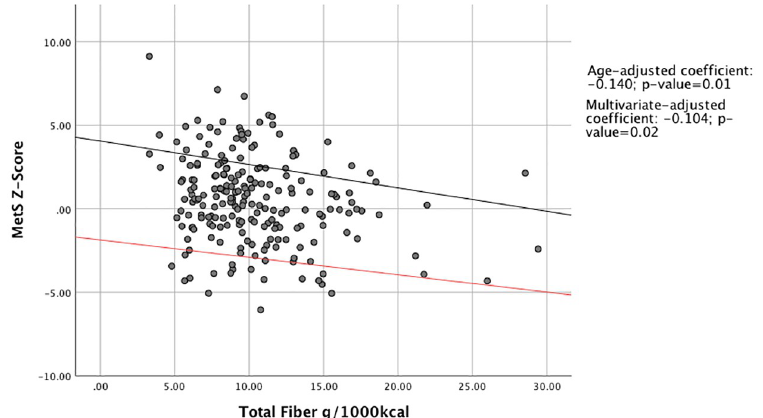
Fig 1. Association between total fiber intake and MetS Z-score. Abbreviations: MetS, Metabolic Syndrome. Linear regression model was used to predict association between daily fiber intake and MetS z-score. The black regression line indicates age-adjusted linear regression, for which the coefficient is -0.140. The red line indicates multivariate-adjusted regression, for which the coefficient is -0.104. Means were adjusted for age, BMI, smoking, education, marital status, total physical activity, and total energy intake. Both lines are statistically significant.